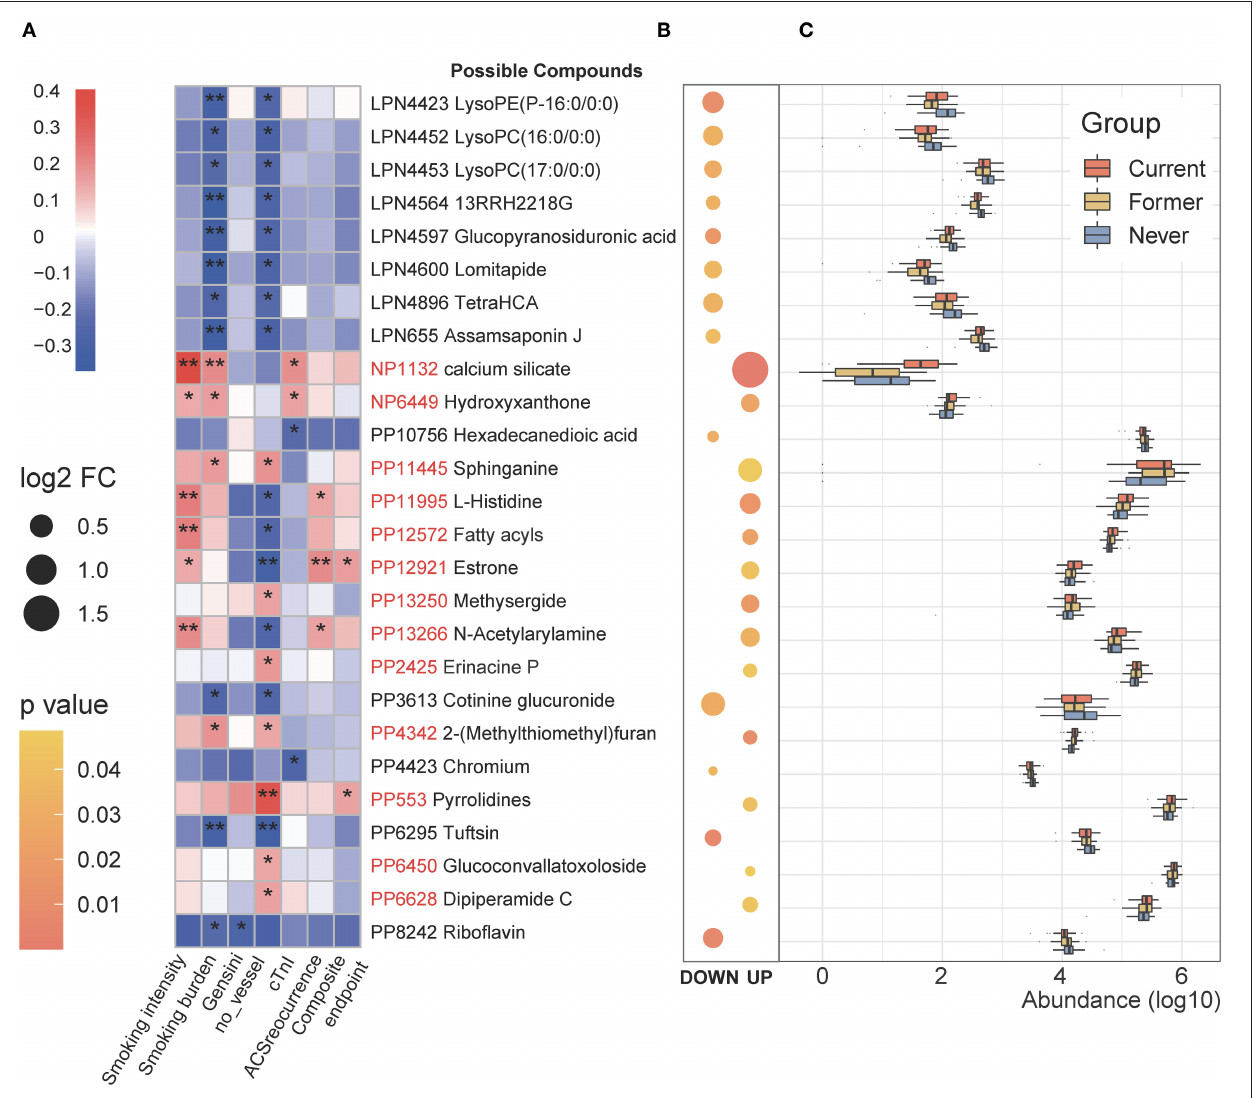
FIGURE 2 | Identification of the major smoking-associated serum metabolomic features correlated with clinical phenotypes. (A) Spearman correlations between smoking-associated metabolic features and clinical outcomes as well as indicators of disease severity in patients with CAD. * p < 0.05, ** p < 0.01. (B) Fold of change and p -values of important metabolomic features. The left column shows the smoking-negative metabolomic features; the right column shows the smoking-positive metabolites. Bubble size indicates the relative fold change in comparison between current and never smokers. Log2 FC, Log2 (the fold of change), Current vs. Never smokers. (C) Changes in important smoking-associated metabolomic features among the three